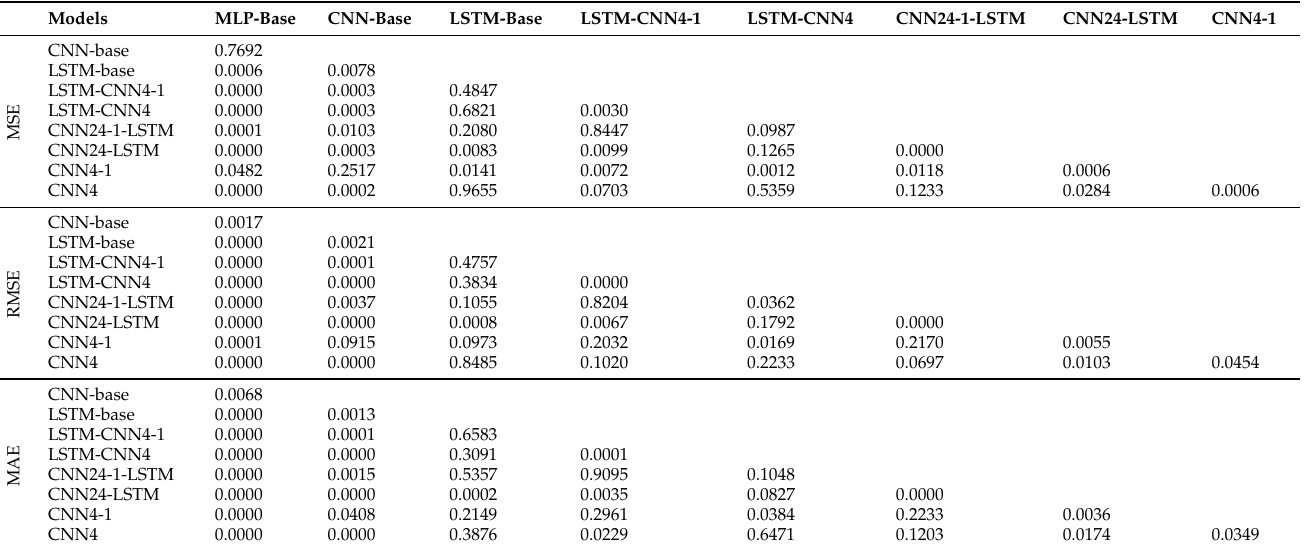
Table 4. The results of paired t -test analysis ( p -values) performed on the monthly calculated perfor- mance